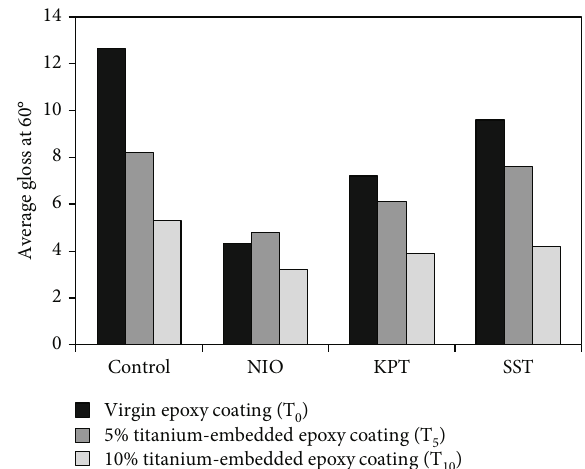
Figure 2: The gloss of the virgin epoxy coating (T titanium-impregnated epoxy coatings (T exposure (NIO and KPT) and salt spray testing